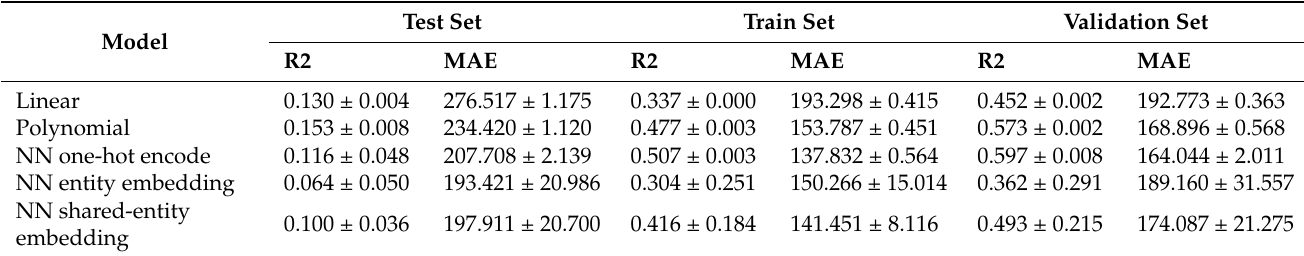
Table 8. Model performance without using sheeting-color as the feature.